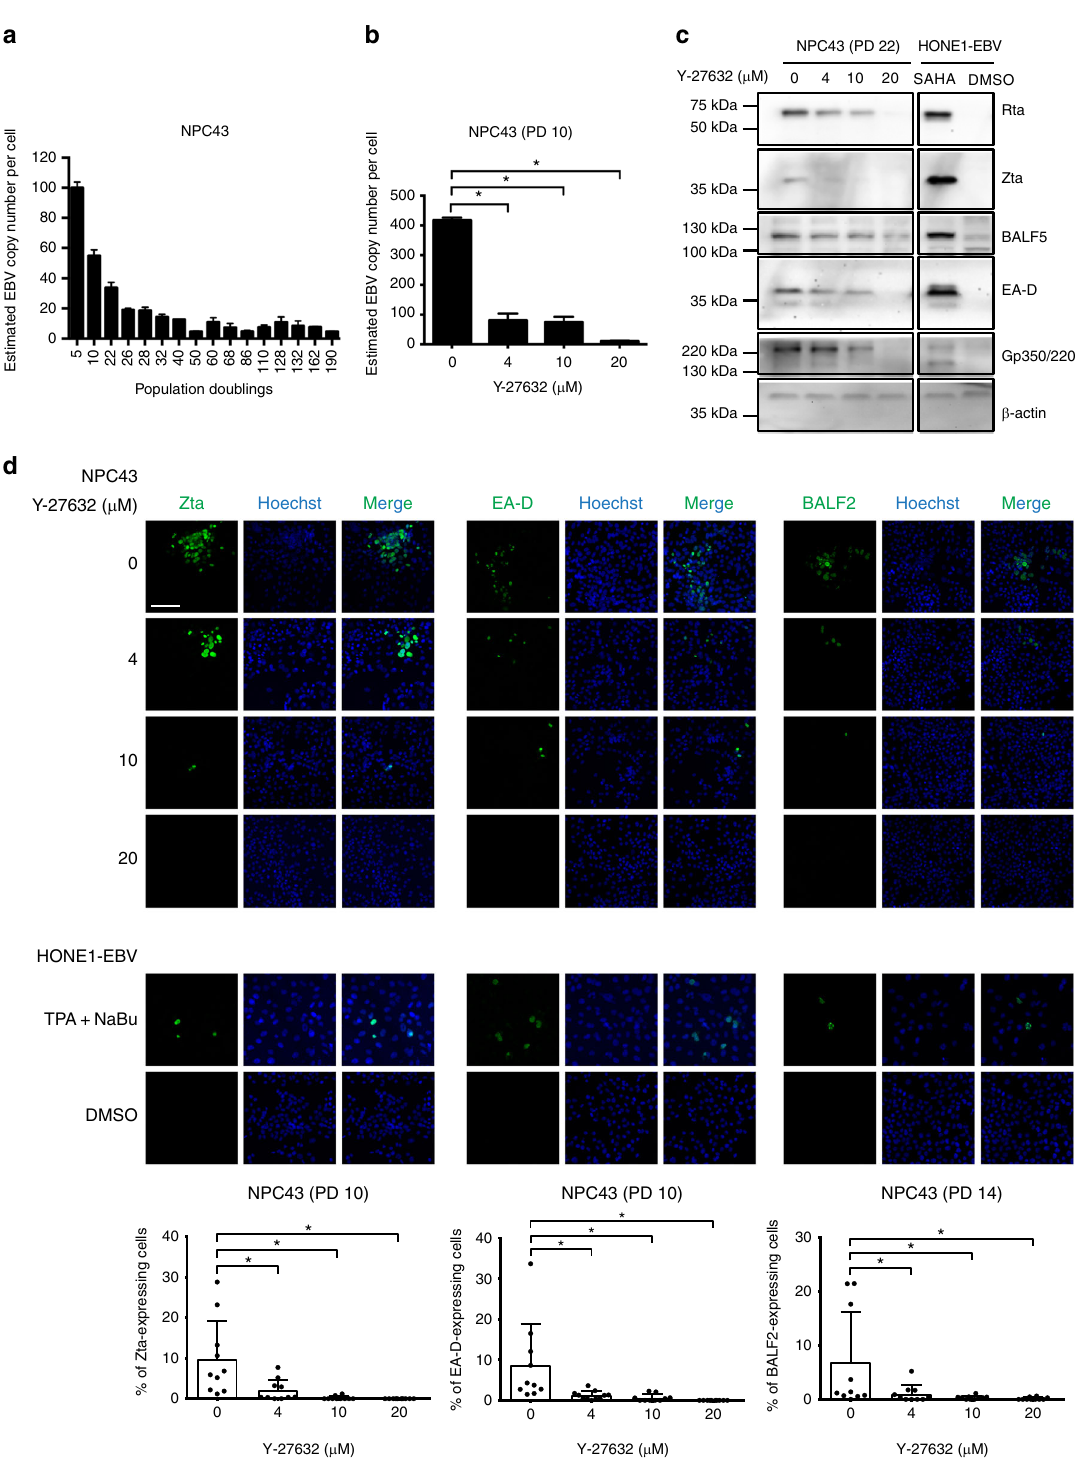
NPC are the homozygous deletion of 9p21.3 including the CDKN2A / CDKN2B loci in three PDXs (Xeno23, 47 and 76) and ampli fi cation of CCND1 on 11q13 in NPC43 cell line. Over- expression of cyclin D1 has been shown in our previous study to support stable EBV infection in nasopharyngeal epithelial cells 23 . ( PDL1 ) and PDCD1LG2 ( PDL2 ) genes was found in Xeno23, and homozygous deletions of TGFBR2 on 3p24 were found in